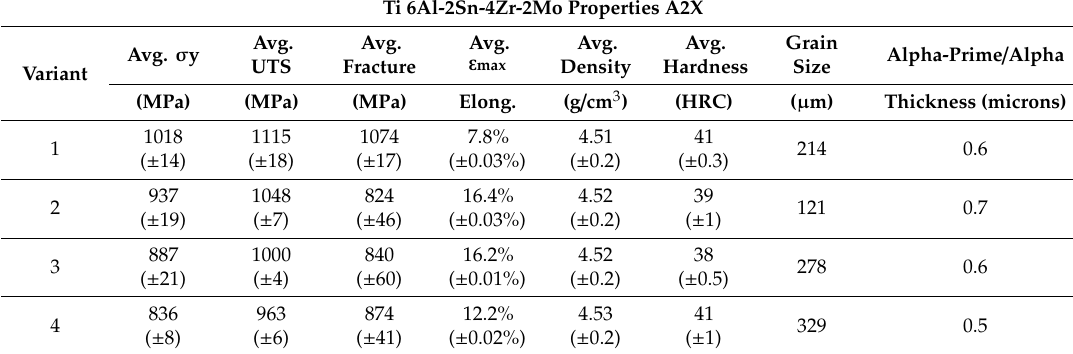
Table 4. Mechanical Properties of Ti 6Al-2Sn-4Zr-2Mo specimen variants built on an ARCAM A2X system.